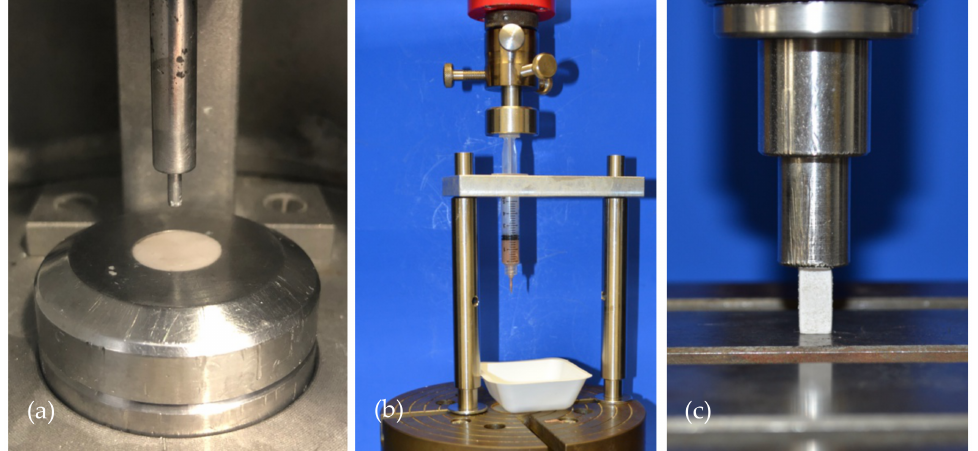
Figure 1. Overview of the test set-up for the Gilmore Needle Test, injectability testing and compressive strength testing. ( a ) The Gilmore Needle Test was conducted according to ASTM Standard C266-99 for both cement formulations in a custom-made humidity chamber. ( b ) Injectability testing was done by applying the load of the materials testing machine on the handle of the cement-filled syringe. ( c ) Compressive strength was done by placing cuboid samples of 12 mm × 6 mm × 6 mm under the indenter of the materials testing machine. Samples were axially loaded until failure with 1